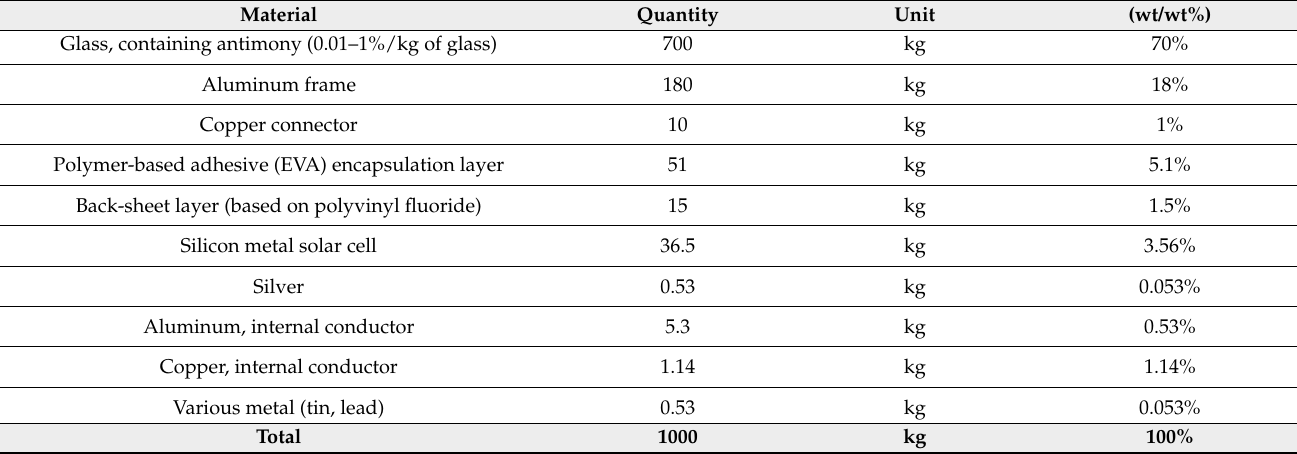
Table 1. Material composition of a photovoltaic module